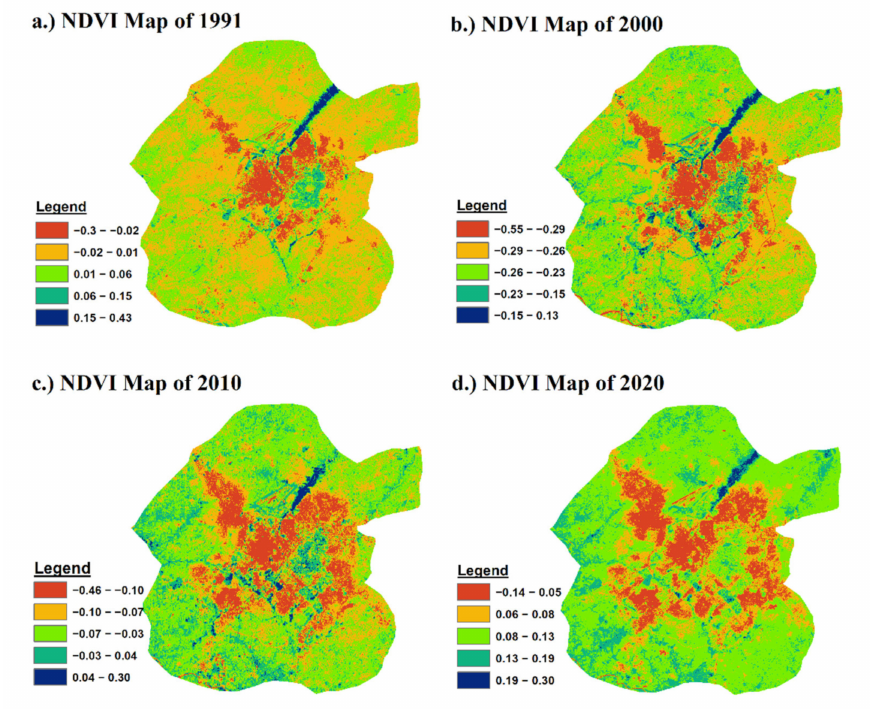
Figure 9. NDVI Maps of Kano Metropolis in ( a ) 1991, ( b ) 2000, ( c ) 2010, and ( d )